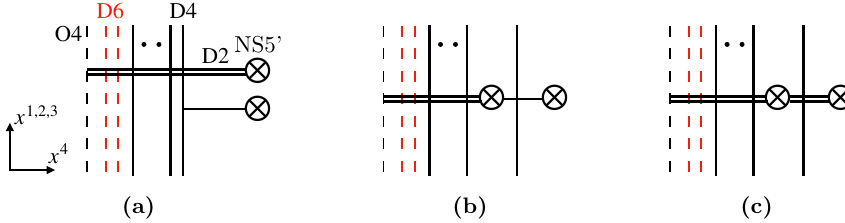
Figure 28. (a): the brane configuration corresponding to the monopole screening sector v = + e N for the product ’t Hooft operator T · T V . (b): a brane configuration obtained by moving the top ∧ 2 V NS5’-brane to the left. (c): a brane configuration obtained by moving the bottom NS5’-brane to the left.